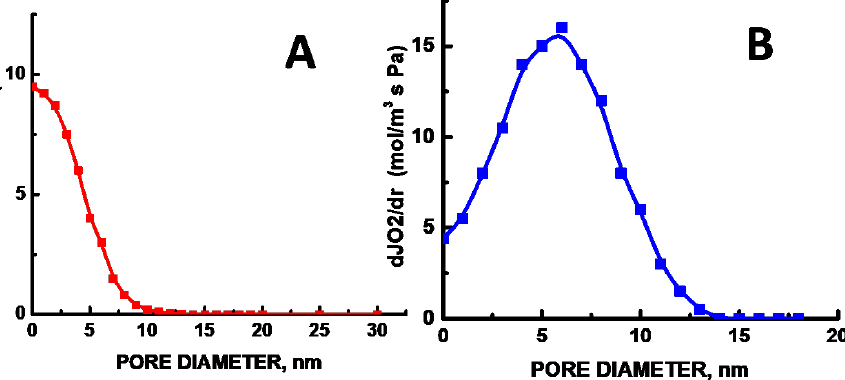
Figure 6. ( A ) Oxygen permeance and ( B ) pore size distribution of the UHMWPE materials with tensile strain ε = 250%.